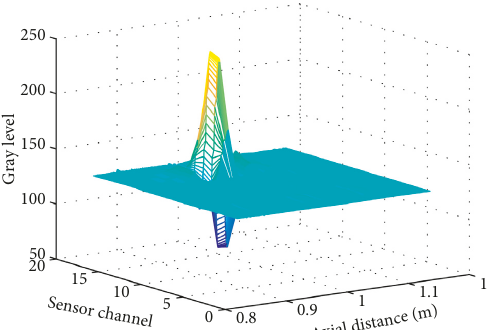
Figure 9: The normalization results from a representative sample.